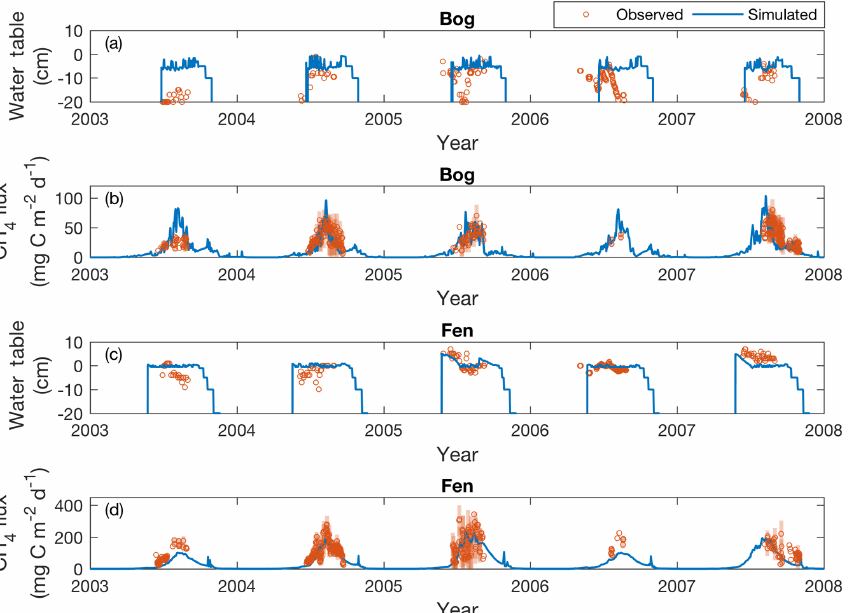
Figure 6. Simulated (solid lines) and measured (open circles) water table depths and daily CH 4 emissions at the bog and fen from 2003 to 2007. Shaded bars are the standard deviations of the daily CH 4 emissions measured across the subsites under each peatland type.